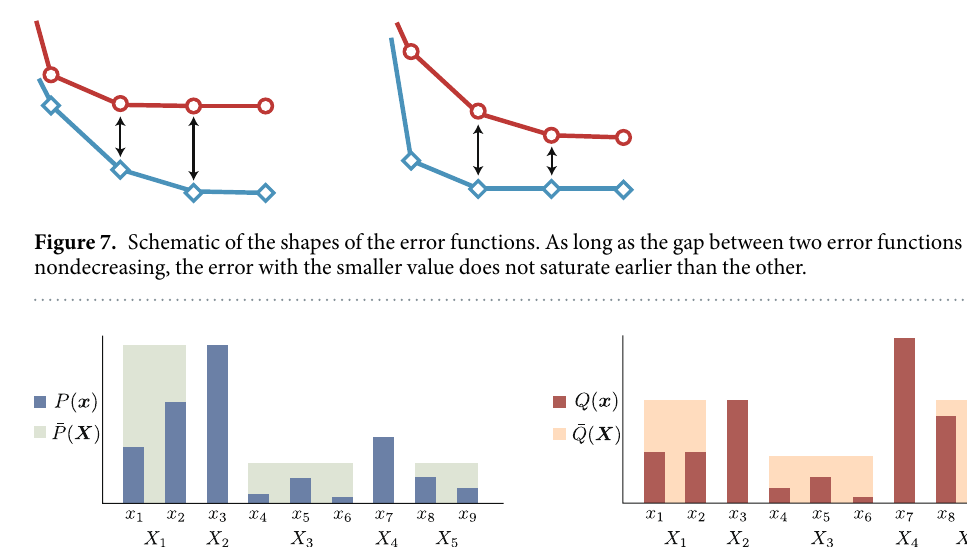
Figure 8. Example of the refinement of the probability distributions. We can regard P ( x ) and Q ( x ) as the refinements